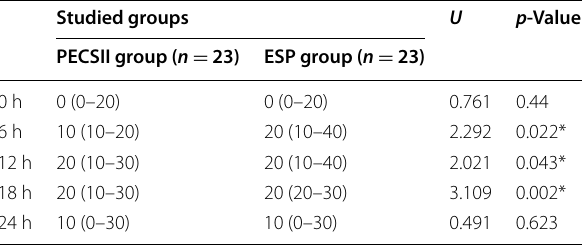
Data were expressed in median (range). * P < 0.05 statistically is significant. U Mann-Whitney test. PECSII modified pectoral plane block, ESP erector spinae plane block